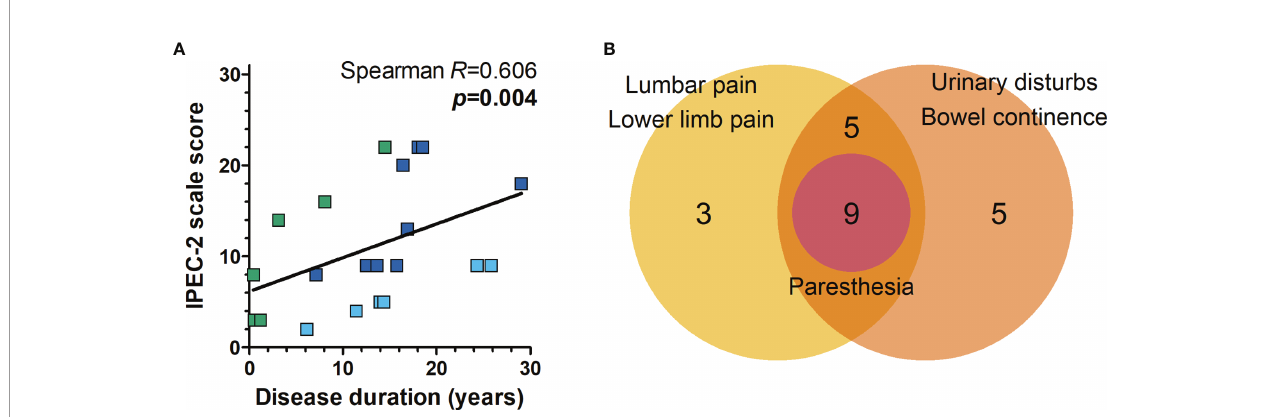
FIGURE 2 | Neurological impairment associated with HAM/TSP. (A) The severity of neurological disability was evaluated with the IPEC-2 scale, and the correlation with disease duration (the interval between disease onset and sample collection) was performed with Spearman ’ s correlation rank. HAM/TSP patients were identi fi ed according to the speed of disease progression as very slow (light blue), typical/slow (dark blue) and rapid (green). (B) Combined frequency of patients with multiple neurological manifestations other than motor impairment in HAM/TSP. All patients with paresthesia presented with lumbar and/or lower limb pain in addition to urinary and/or bowel